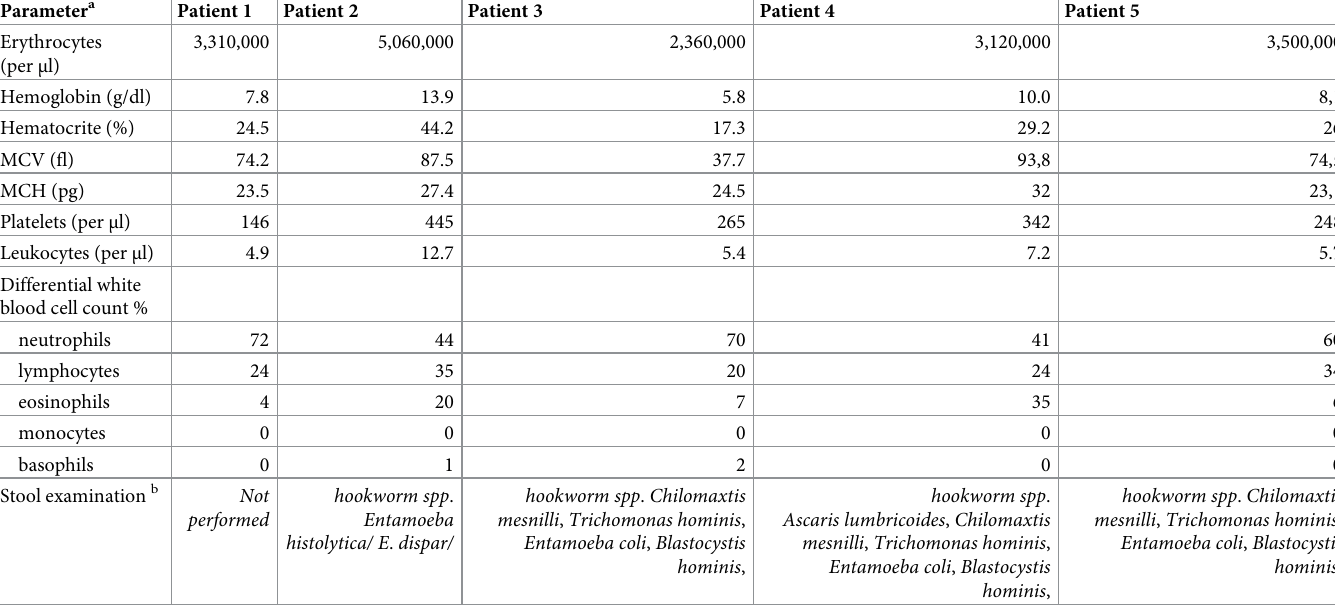
Table 2. Hematological and other laboratory